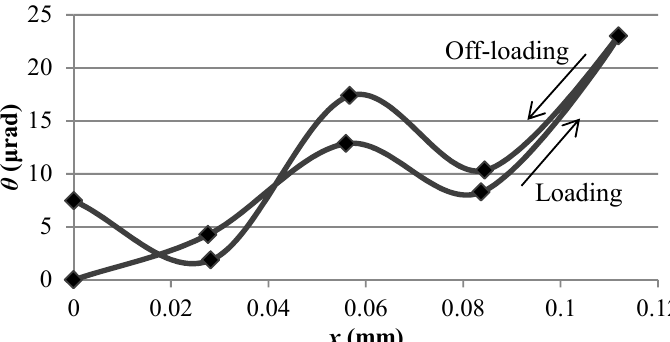
Figure 7. Measured parasitic rotations of the moving block of the LBM additive-manufactured flexure parallel mechanism with reference to the dominating translational displacements.